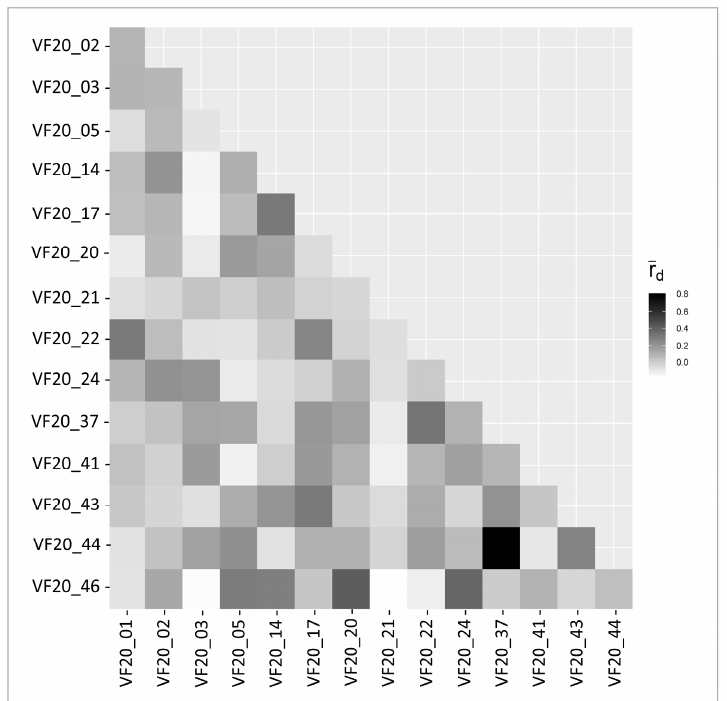
Figure 2. Linkage disequilibrium of the developed genomic simple sequence repeats (gSSRs). Pair- wise r d was calculated and displayed in a heatmap to infer if any loci were associated. The darker the square, the more of an association there is between the two loci. The lighter the square, the less of an association.